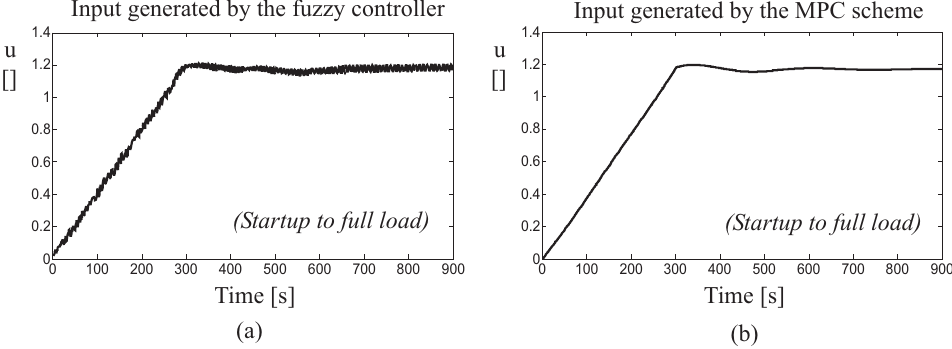
Figure 12. Hydroelectric plant input u generated ( a ) by the fuzzy controller and ( b ) from the MPC